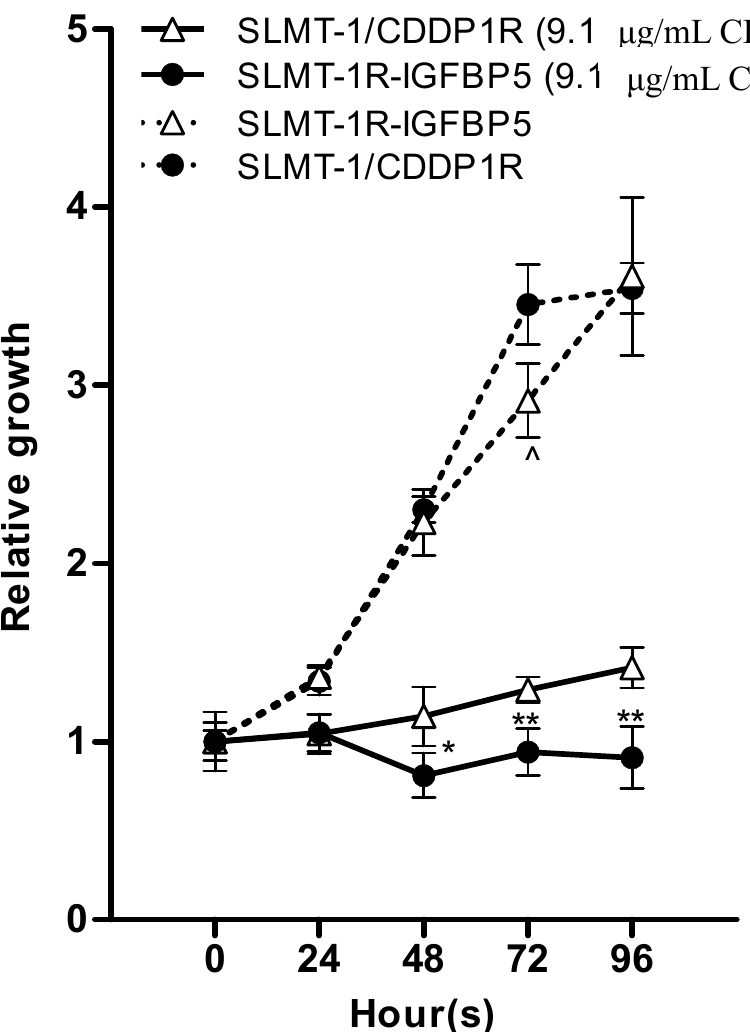
Figure 6. IGFBP5 expression vector reversed cisplatin-resistance. ( A ) Relative MTS activity of SLMT-1/CDDP1R, SLMT-1R-IGFBP5 and SLMT-1R-pcMV3 cells. Relative MTS activities were expressed as means ± standard error compared with the MTS activities at zero CDDP concentration and analyzed using one-way ANOVA. SLMT-1R-IGFBP5 was compared to SLMT-1R-pcMV3 with * p < 0.05 and ** p < 0.01. SLMT-1R-IGFBP5 was more sensitive to CDDP than SLMT-1R-pcMV3 and SLMT-1/CDDP1R. ( B ) Relative MTS activity of SLMT-1, SLMT-1-IGFBP5 and SLMT-1-pcMV3 cells after 48 h treatment with cisplatin at different concentrations compared to SLMT-1. SLMT-1, SLMT-1-IGFBP5 and SLMT-1-pcMV3 cells showed similar sensitivity to cisplatin. ( C ) Relative growth of SLMT-1/CDDP1R and SLMT-1R-IGFBP5 cultured in medium with or without 9.1 μ g/mL cisplatin. Relative growth was expressed as means ± standard error compared with the MTS activities at zero hour and analyzed using one-way ANOVA. SLMT-1R-IGFBP5 (9.1 μ g/mL CDDP) was compared to SLMT-1/CDDP1R (9.1 μ g/mL CDDP) with * p < 0.01 and ** p < 0.001. SLMT-1R-IGFBP5 was compared to SLMT-1/CDDP1R with ^ p < 0.001. Growth of SLMT-1R-IGFBP5 cells was significant inhibited than SLMT-CDDP/1R in the medium with 9.1 μ g/mL CDDP, demonstrating the reversal of CDDP-resistance by IGFBP5 expression vector.